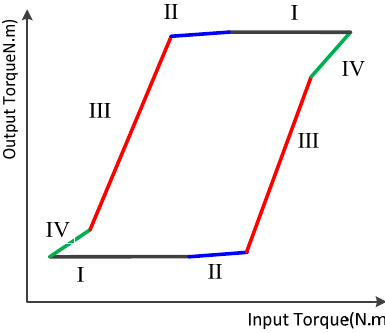
Figure 6. Force transfer characteristics of closed-loop